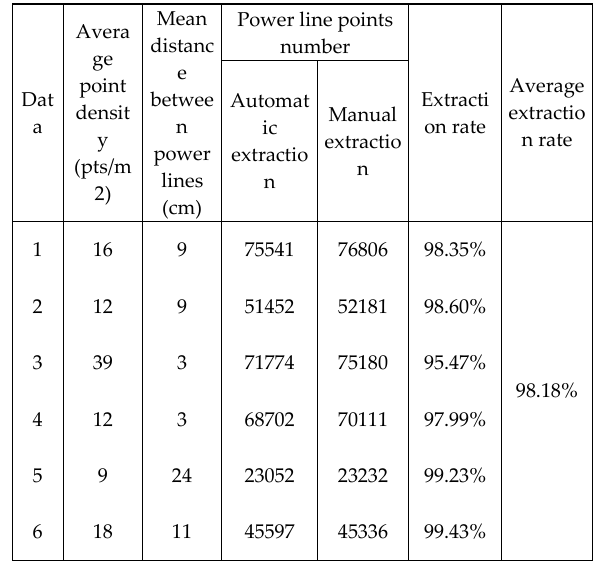
Table 3. Statistics of power line extraction results.